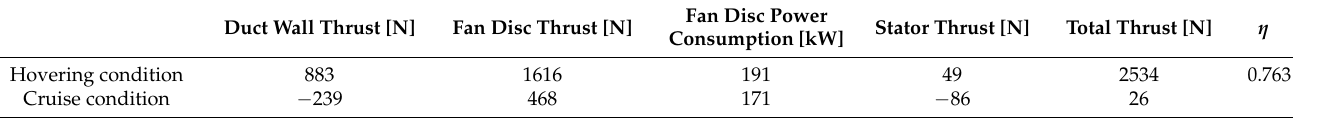
Table 8. The thrust of optimized DFW unit in hovering and cruise conditions.